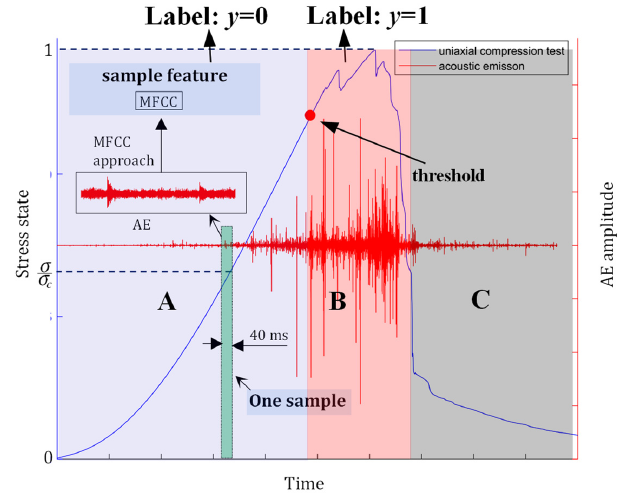
Figure 2. Waveform, segmentation, feature extraction, and labeling of AE signal.